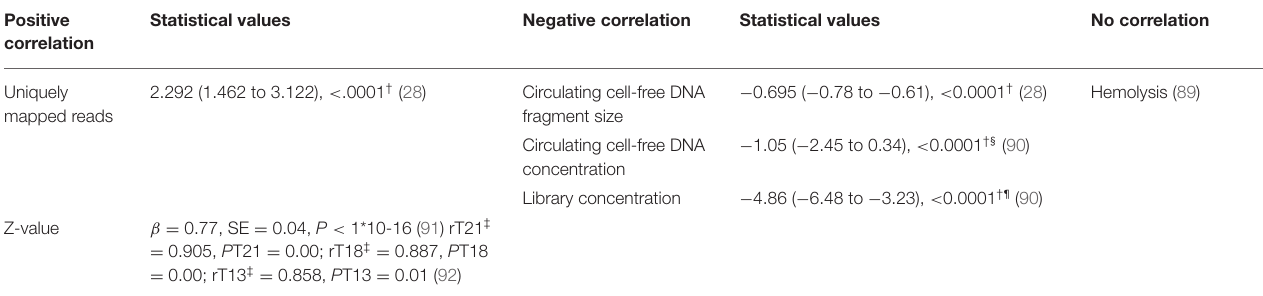
TABLE 3 | Experimental factors that are associated with fetal fraction of circulating DNA. Positive